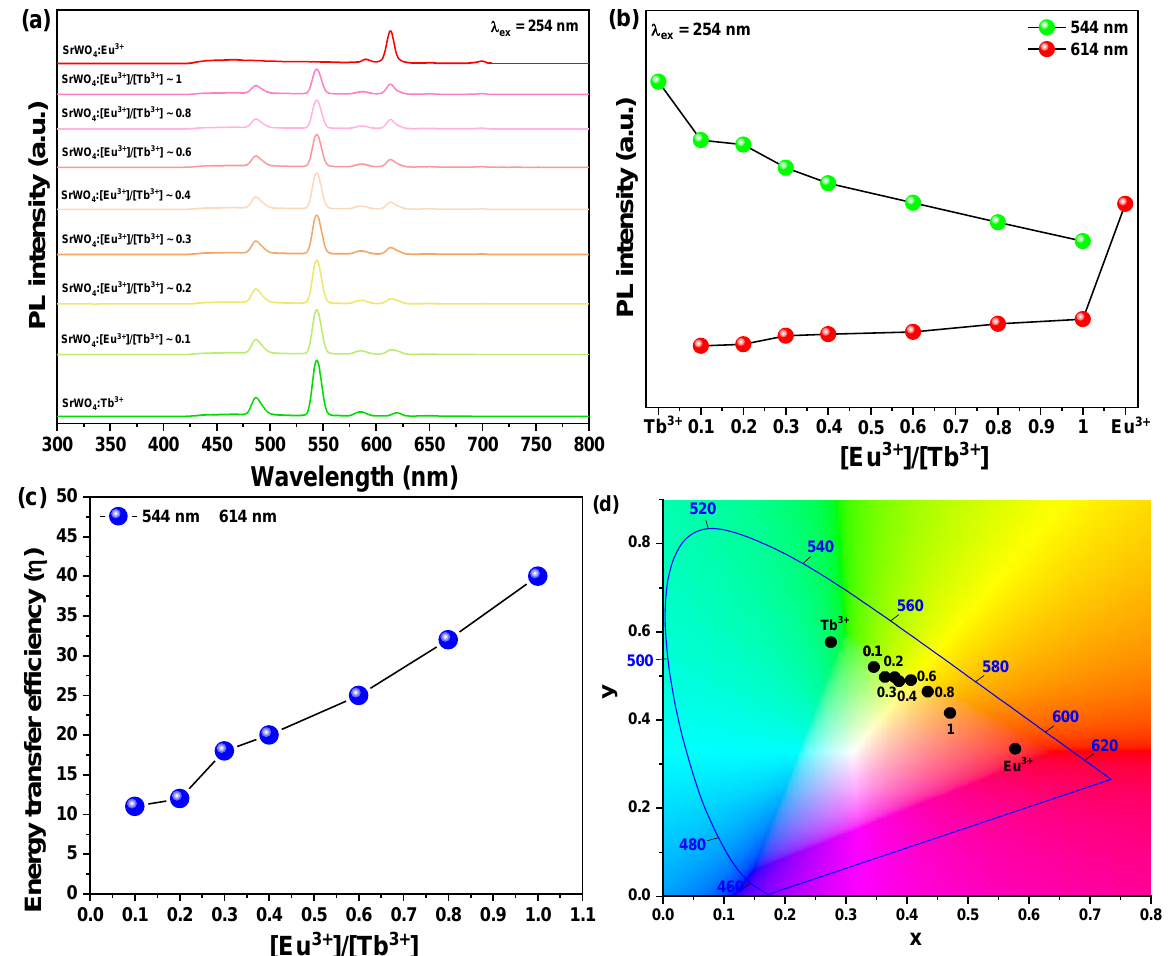
Figure 7. ( a ) Pl spectra under 254 nm, ( b ) change in PL intensity, ( c ) energy transfer efficiency, and ( d ) CIE coordination SrWO 4 :[Eu 3+ ]/[Tb 3+ ].